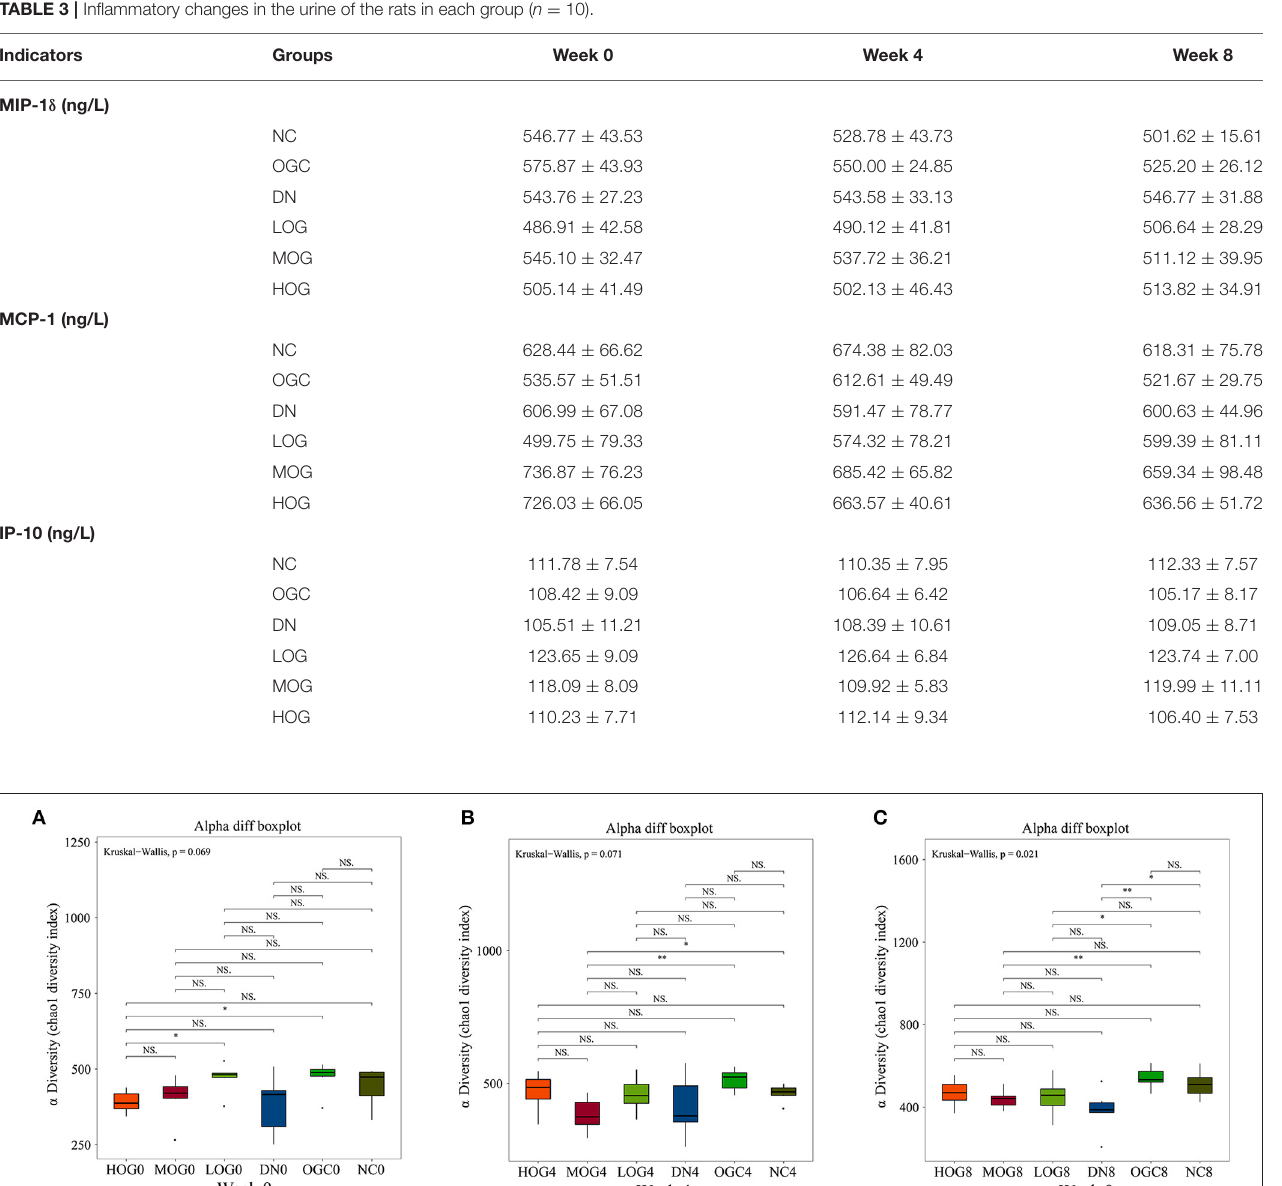
among each group ( P > 0.05). At week 8, the Chao1 and Shannon’s diversity index decreased significantly in the DN group compared with those in the NC group, while the LOG, MOG, and HOG groups showed higher Chao1 and Shannon’s diversity index than those of the DN group ( P < 0.05). Among them, the increase in the HOG group was the most obvious. There was no statistically significant difference between the NC and OGC groups at all three time points ( P > 0.05). 0.05). However, there was no significance difference among